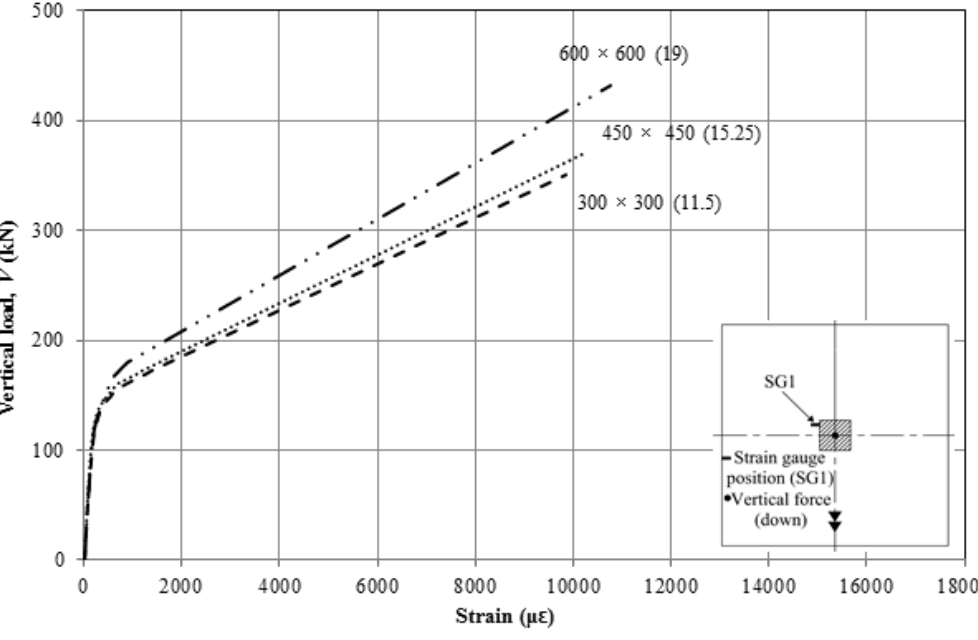
Figure 13. Load-strain relationship for the models with different perimeter-to-depth